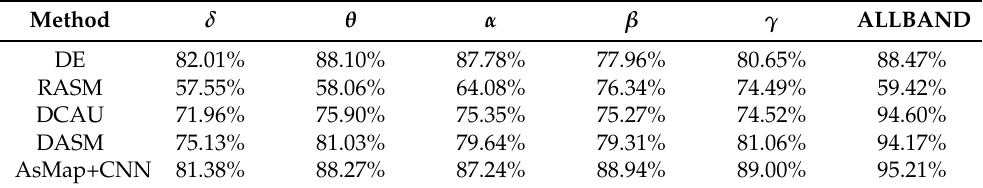
Table 3. Arousal classification accuracy obtained using different feature extraction techniques on frequency